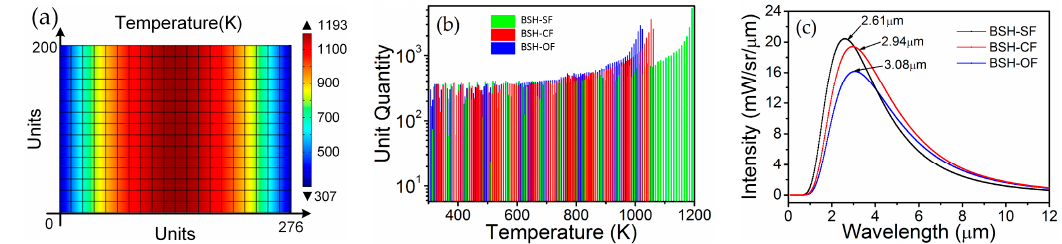
Figure 5. ( a ) Rectangle mesh in the heater of BSH-SF emitter; ( b ) Statistical comparison of temperature distributions of BSH-SF, BSH-CF, and BSH-OF emitters at driving voltage of 12 V; ( c ) Calculated IR spectra for theBSH-SF, BSH-CF, and BSH-OF emitters at driving voltage of 12 V.